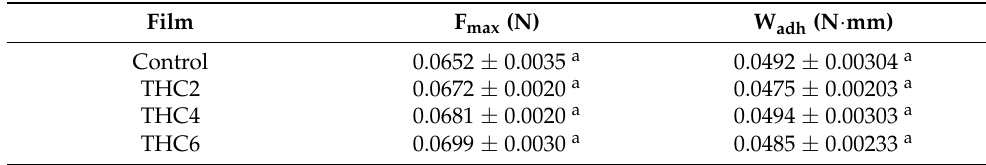
Table 3. Mucoadhesive properties of collagen scaffolds in terms of the detachment force (F max ) and the work of adhesion (W adh ). Means followed by the same letter in the same column do not differ statistically among themselves by Tukey test ( p <